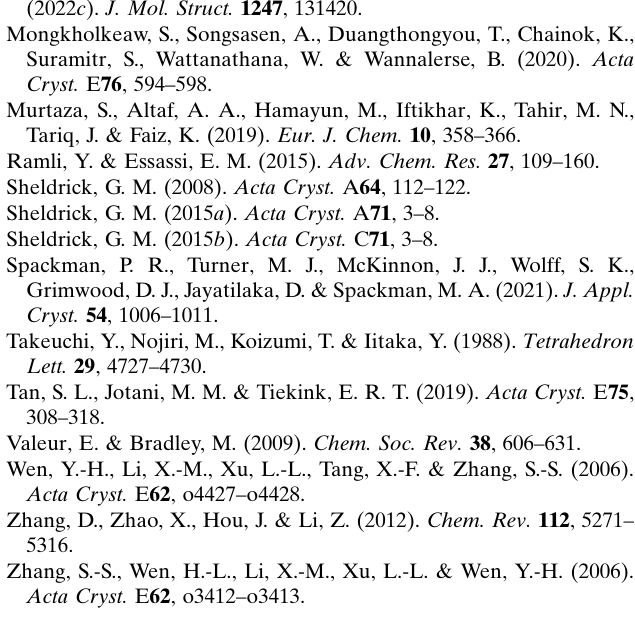
riding contributions with isotropic displacement parameters fixed at 1.2 U (C) (1.5 for the methyl group). The N-bound H eq atom was found in a difference-Fourier map and refined with a DFIX 0.91 0.01 instruction and an independent isotropic displacement parameter.